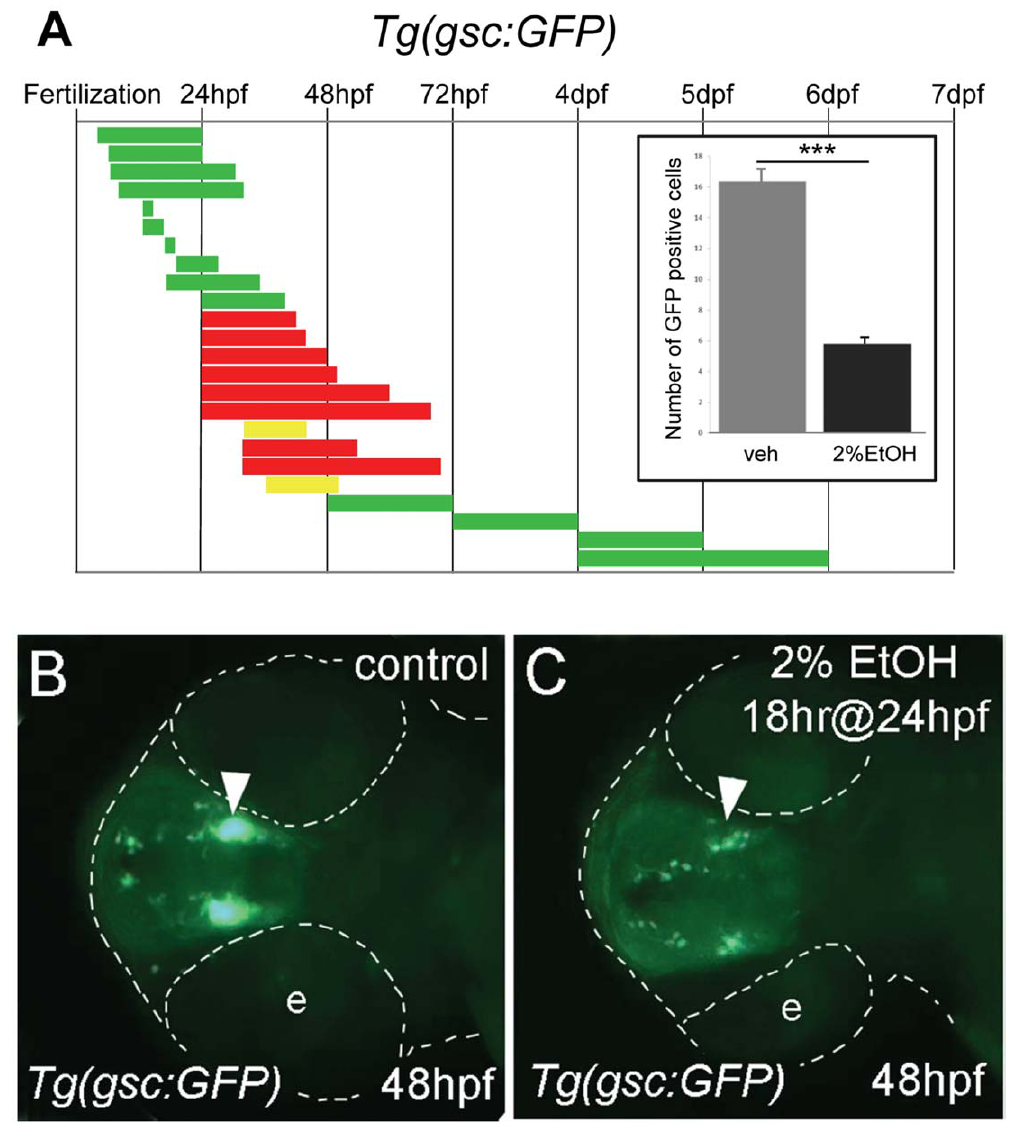
Figure 1. Ethanol exposure reduces the number of gsc:GFP expressing neurons. A , the duration and embryonic stage of 2% ethanol treatments in Tg(gsc:GFP) embryos are illustrated with solid bars. Colors indicate the treatment had no effect (green), slightly reduced (yellow), or reduced (red) GFP expression. Inset , the average numbers of GFP positive cells in the preoptic area (POA) of 72 hpf embryos treated with 2% ethanol for 24 hrs at 24 hpf (n=12) and vehicle control (n=10). Ethanol treatment resulted in a highly significant reduction of GFP-expressing cells in the POA, *** p , 0.001. Error bars represent SEM. B, C , ventral views of Tg(gsc:GFP) embryos at 48 hpf. B , is the control. C , treated with 2% ethanol for 18 hrs at 24 hpf. GFP expression in the neuroendocrine preoptic area (arrowheads) was dramatically reduced in the embryos exposed to ethanol. The embryo and eyes (e) are outlined (dashed white line). doi:10.1371/journal.pone.0053991.g001 neurons are sensitive to ethanol during an earlier developmental and X, in facial, glossopharyngeal and vagal sensory ganglia, and period than the gsc:GFP -expressing POA neurons. in Rohan-Beard primary sensory neurons and motor neurons of the spinal cord [52]. A series of chronic exposures covering the Tg(pax2a:GFP)e1 (pGFP5.3) is expressed in the mid-hindbrain first six days of development was used to identify ethanol-sensitive border, rhombomeres 3 and 5, one telencephalic area and three periods (Figure 2A). Ethanol exposure for 24 hrs starting at 70% diencephalic areas, as well as in the VIIIth cranial nerve ganglion, epiboly abolished isl1:GFP expression in the two forebrain nuclei the hindbrain and spinal cord interneurons [53]. Early ethanol and the mesencephalic cluster, and reduced expression in cranial exposure, from dome stage to 24 hpf, did not appear to affect motor nuclei III and IV (Figure 2B–F). In contrast, ethanol pax2a:GFP expression, whereas treatment for 24 hrs starting at the treatment for 24 hrs at 24 hpf only resulted in a slight and variable 14 somite stage or at 24 hpf resulted in an apparent reduction of reduction of isl1:GFP expression in the forebrain nuclei, and pax2a:GFP -expressing neurons in the hindbrain. In addition, a treatment later than 48 hrs had no effect on isl1:GFP expression small group of pax2a:GFP neurons were eliminated in the forebrain (Figure S3). This indicates that isl1:GFP -expressing forebrain